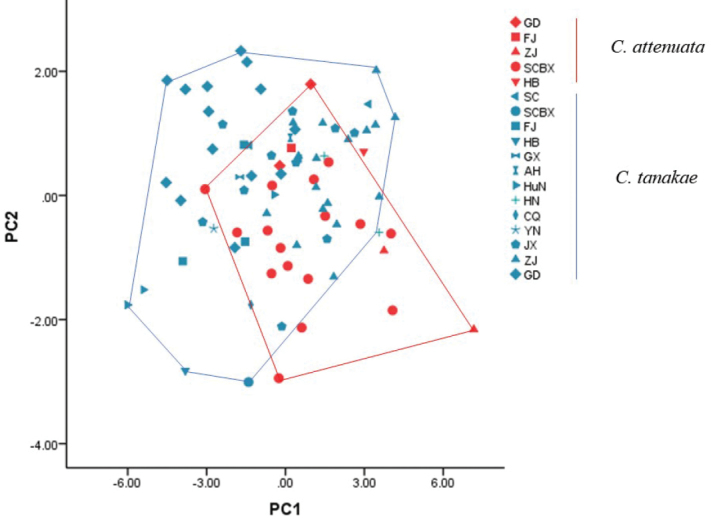
Scatter plot of C.
attenuata (red) and C.
tanakae (blue) sample distribution over PC1 and PC2 axes constructed based on external and skull morphological variables. Different symbols represent different populations. GD: Guangdong, FJ: Fujian, ZJ: Zhejiang, SCBX: Baoxing, Sichuan, HB: Hubei, SC: Sichuan, GX: Guangxi, AH: Anhui, HuN: Hunan, HN: Hainan, CQ: Chongqing, YN: Yunnan, JX: Jiangxi